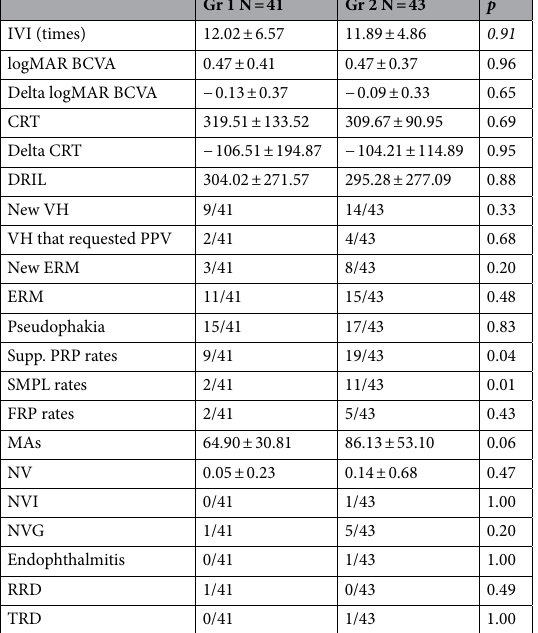
Table 2. Outcomes at 24 months after treatment. IVI intravitreal injection, VH vitreous hemorrhage, ERM epiretinal membrane, supp. Supplementary, PRP panretinal photocoagulation, SMPL subthreshold micropulse laser, logMAR BCVA best-corrected visual acuity in the logarithm of the minimal angle of resolution, CRT central retinal thickness, DRIL Disorganization of the retinal inner layers, NVI neovascularization of iris, NVG neovascular glaucoma, RRD rhegmatogenous retinal detachment, TRD tractional retinal detachment, PPV pars plana vitrectomy, MAs microaneurysms, NV retinal neovascularization.